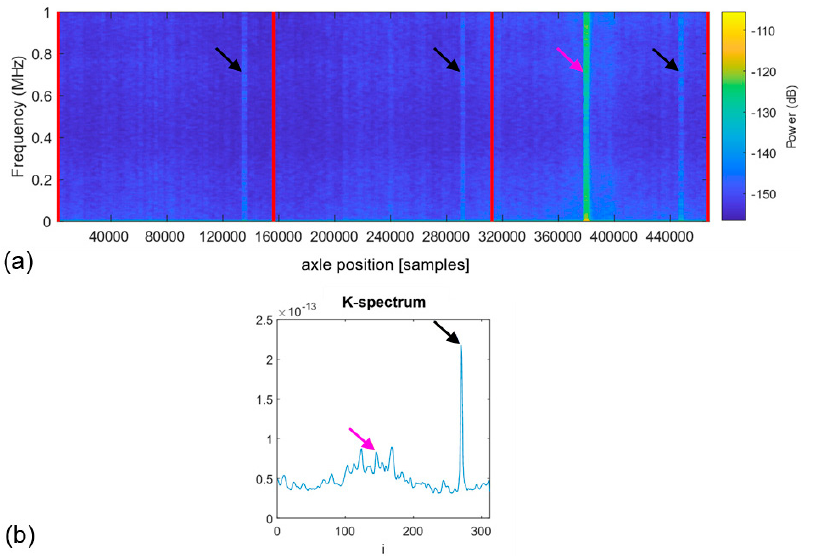
Figure 9. Typical Pulse Integrated Spectrogram corresponding to one axle revolution divided into three segments of equal length and marked by vertical red lines ( a ) and the K -spectrum corresponding to the middle segment ( b ) observed during the late stage of the test, at 52.8 × 10 6 fatigue cycles: two independent damaging processes evolve in parallel. The black arrows indicate the spectral lines corresponding to f fault = 3/ rev and the pink arrows highlight the faults appearing at f fault = 1/ rev